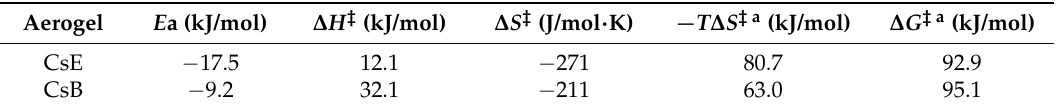
Table 4. Activation energies calculated from D by the Arrhenius Equation (3). Thermo-kinetic parameters: ∆ H ‡ and ∆ S ‡ estimated from the Eyring Equation (7) and ∆ G ‡ calculated at 298.15 K using the Equation